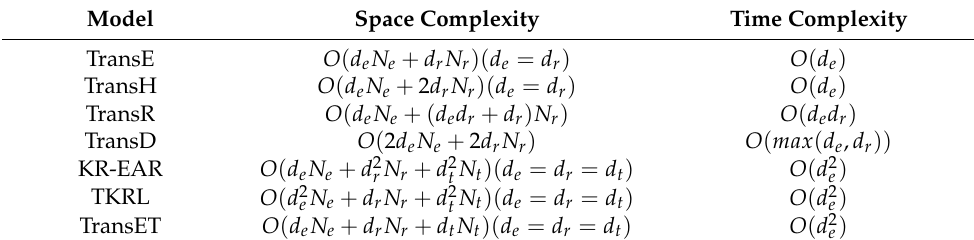
Table 2. Comparison of models in space complexity and time complexity.